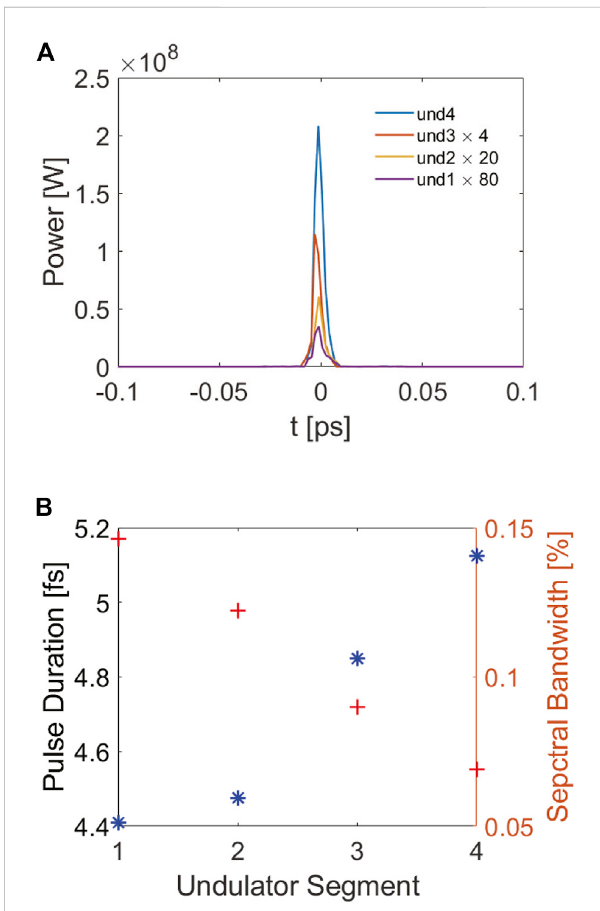
FIGURE 7 (A) Radiation power pro fi les at various undulator segments along RAD2. (B) FEL pulse duration and spectral bandwidth evolutions at various undulator segments along RAD2.